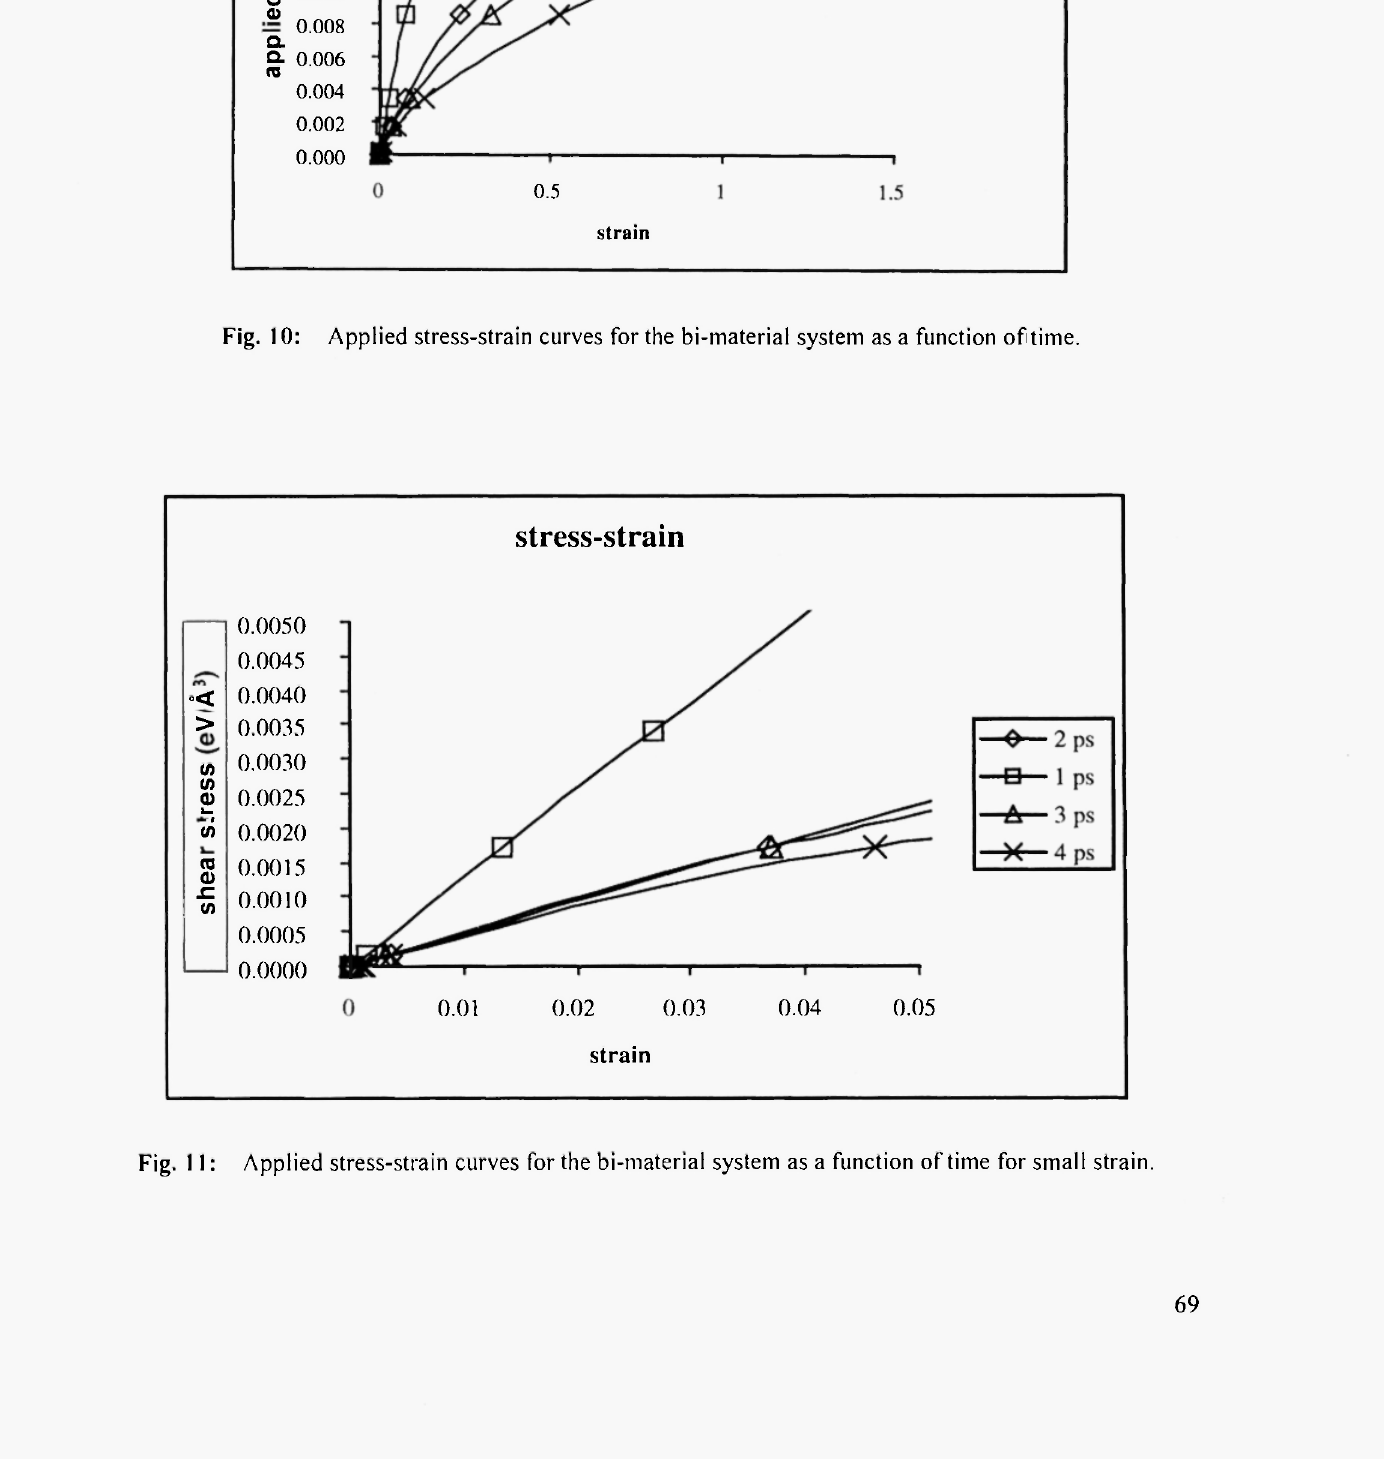
Fig. 10: Applied stress-strain curves for the bi-material system as a function of time.